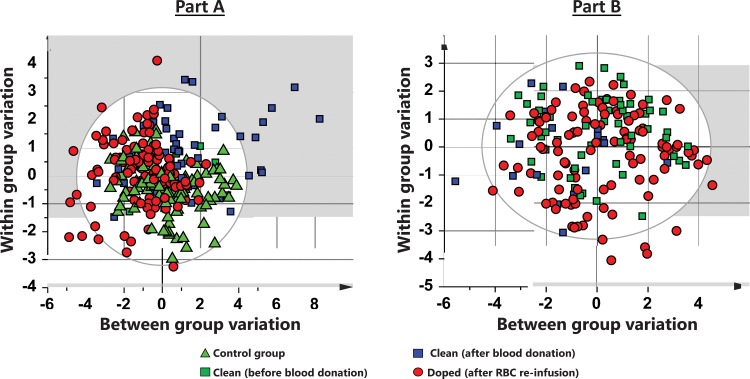
Part A of the Study and Part B of the Study. PCA overview comparing scores scatter plot of Control, Clean, Donated and Transfused and subjects. Observations close to each other are more similar than observations distant from each other. Each marker represents the sum of all hematological variables. Panel A is data from 323 blood samples taken from the Control and Transfusion groups, over a period of 21 week (Fig 1). A PCA analysis including all data from nine hematological variables (Table 5) with N = 323 blood samples and X = 2272 data points (individual hematological data) indicated a separation between Control and Transfusion groups (R2X = 0.56; Q2 = 0.38; significant by R1). Panel B is data from 210 blood samples taken over 10 weeks (Fig 1) where Clean samples are taken before blood donation (green squares), Post donation samples are indicated by blue squares and Doped samples by red circles. R 2 = 0.60, and Q 2 = 0.31. Clean samples from the Control group (▲); Transfusion group before donation (■), Transfusion group after donation (■), Transfusion group after RBC re-infusion (●). Ellips indicates 95% CI.